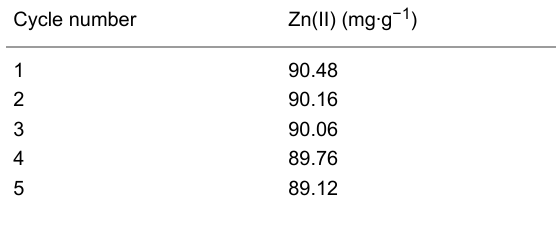
Table 4: Adsorption/regeneration of hybrid material towards